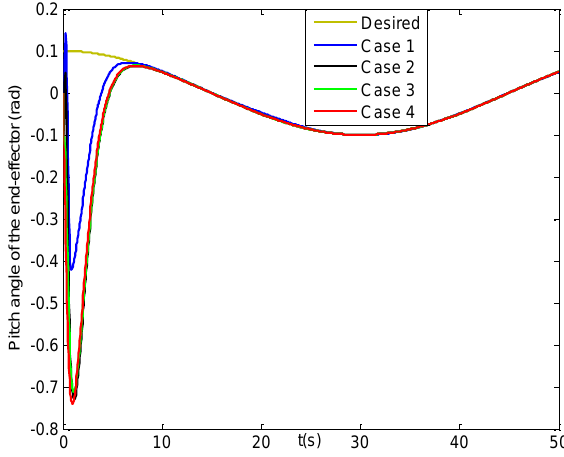
Figure 10. Pitch angles of the end − effector (four cases).